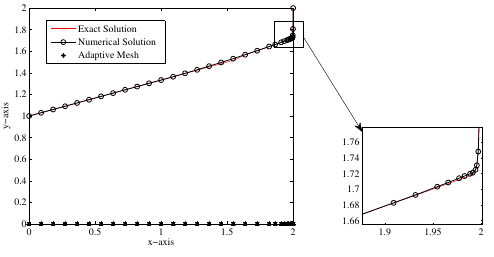
Figure 1. Numerical solution for Example 1 with ε = 2 − 8 , N = 23 (initially)